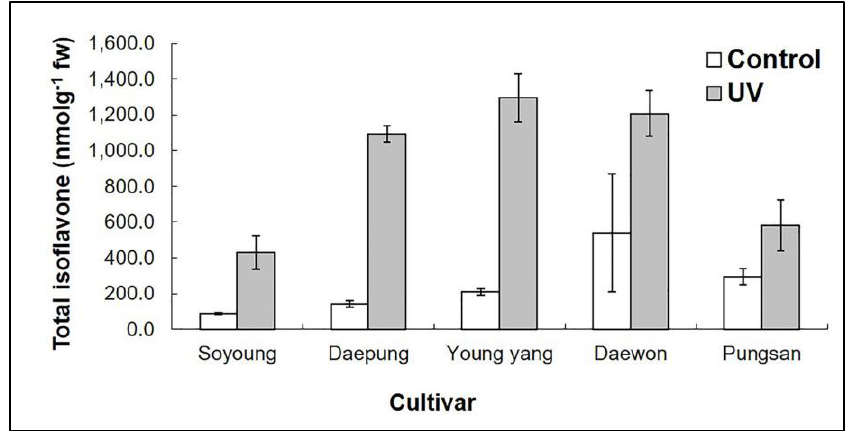
Figure 3. Total isoflavone concentration in different cultivars after 5 min UV-C treatment. The x -axis represents the different cultivars of soybean, whereas the y -axis represents the total isoflavone concentration (unit: nmol g −1 of fresh weight). The error bars represent the means ± standard deviation ( n = 3). Means with the same letter are not significantly different ( p ≤ 0.05).